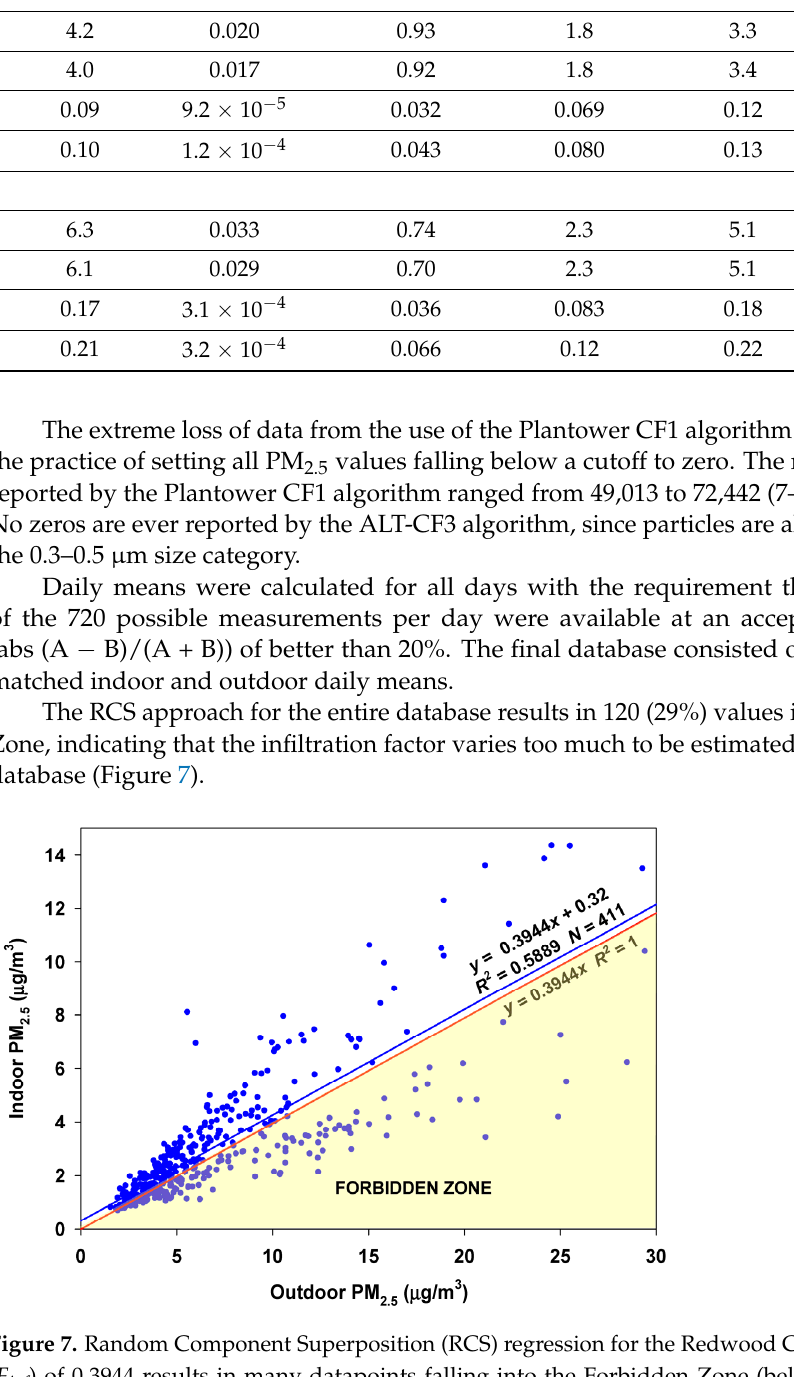
Table 5. All indoor PM 2.5 data ( µ g/m 3 ) and associated precision for monitors 1 and 2 compared for the ALT-CF3 and Plantower CF1 algorithms for the 19-month period 7/3/19 to 2/6/22. N obs.